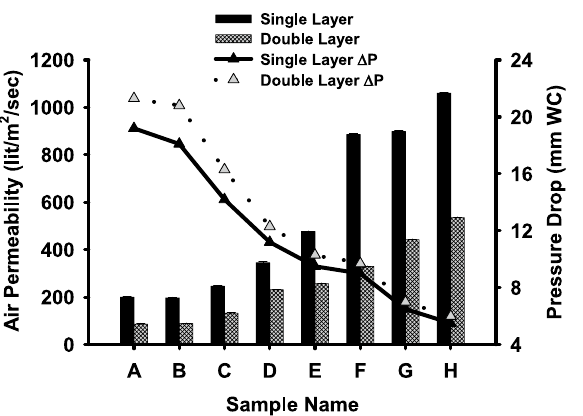
Figure 3. Air permeability and pressure drop of various PP-MB-NW fabric sample (A–H) in single and double layers. The error bars represent the standard deviation of three